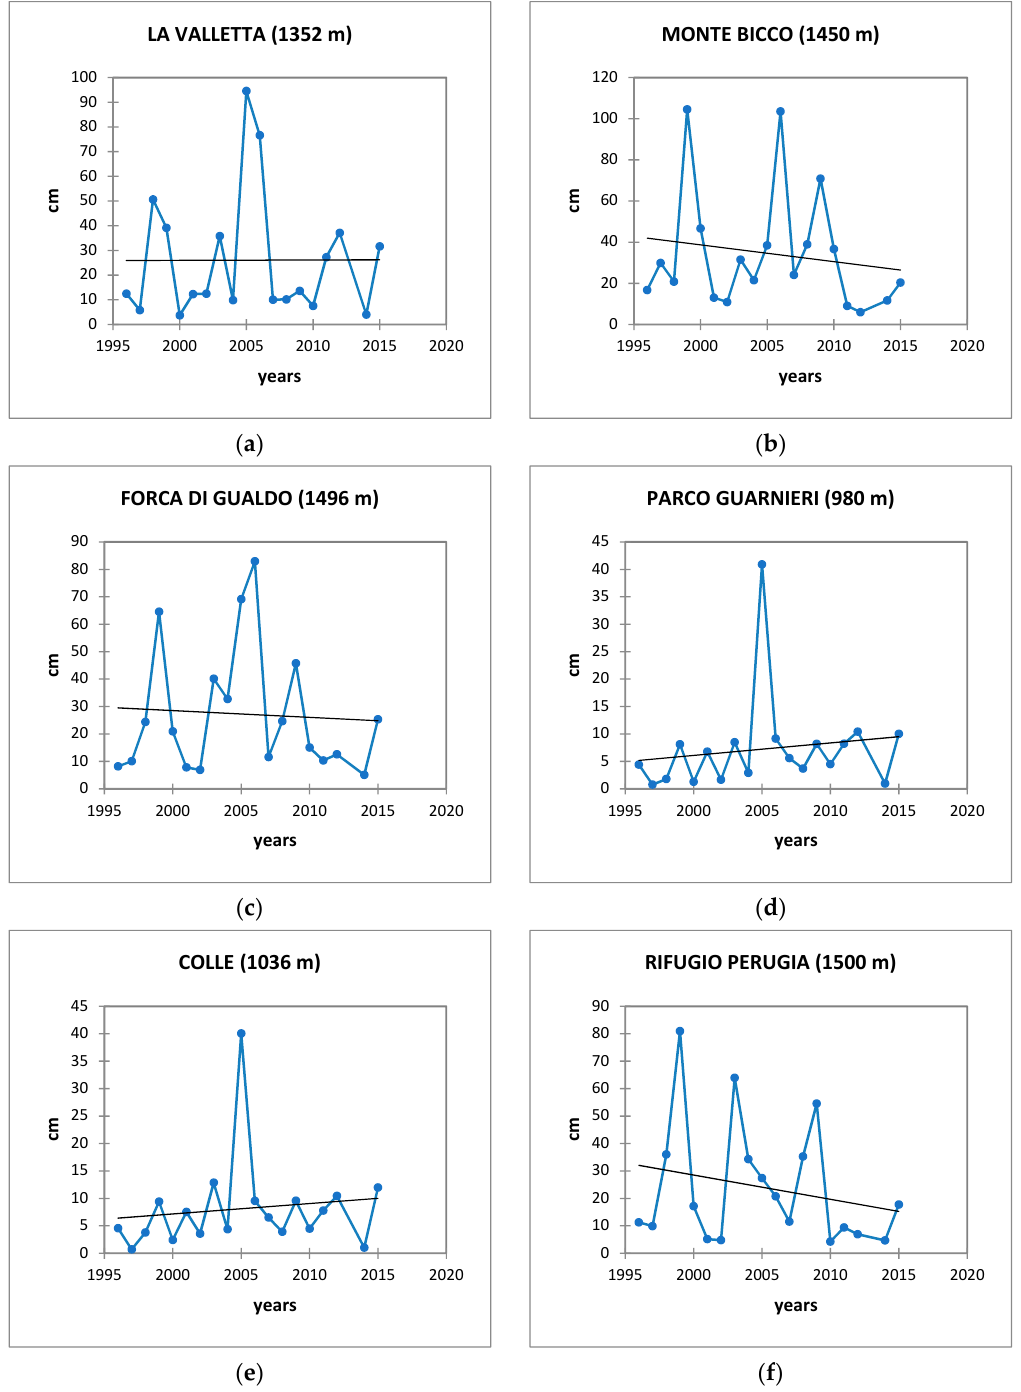
Figure 3. Trend of average annual snow depths from 1991 to 2020, in black the trend line, for the weather stations: ( a ) La Valletta, ( b ) Monte Bicco, ( c ) Forca di Gualdo, ( d ) Parco Guarnieri, ( e ) Colle, ( f ) Rifugio